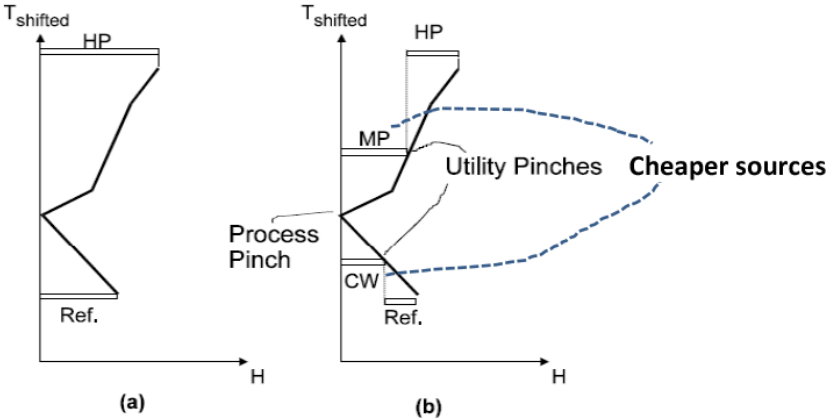
Fig. 34. – Grand composite curve in the search for cheaper sources [10].